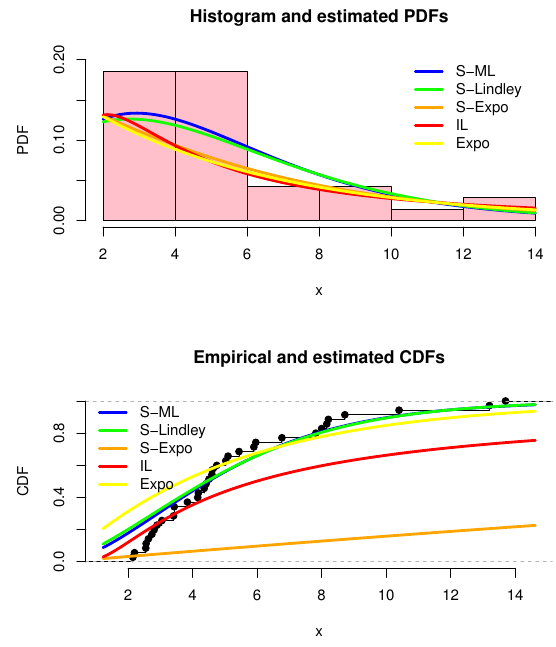
Figure 3. The EPDF and ECDF plot for the survival times of growth hormone medication.